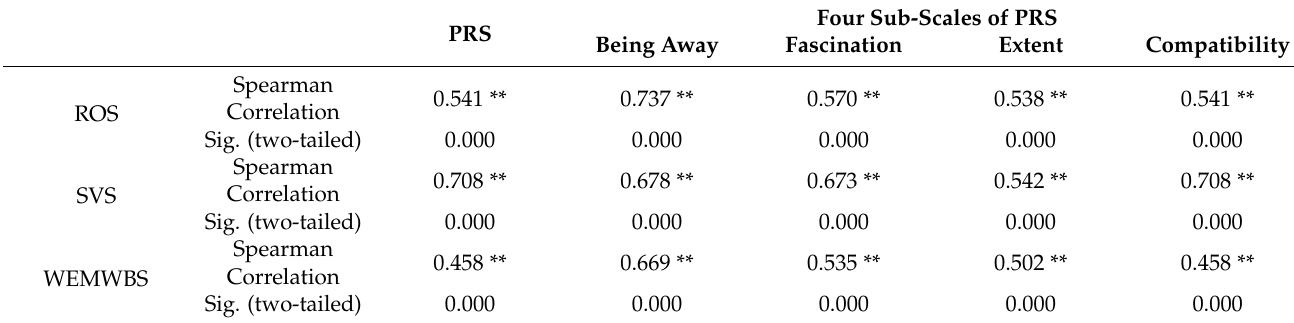
Table 6. Spearman rank correlations between the PRS and four sub-scales of PRS and the ROS, SVS, and WEMWBS. Four Sub-Scales of PRS PRS Being Away